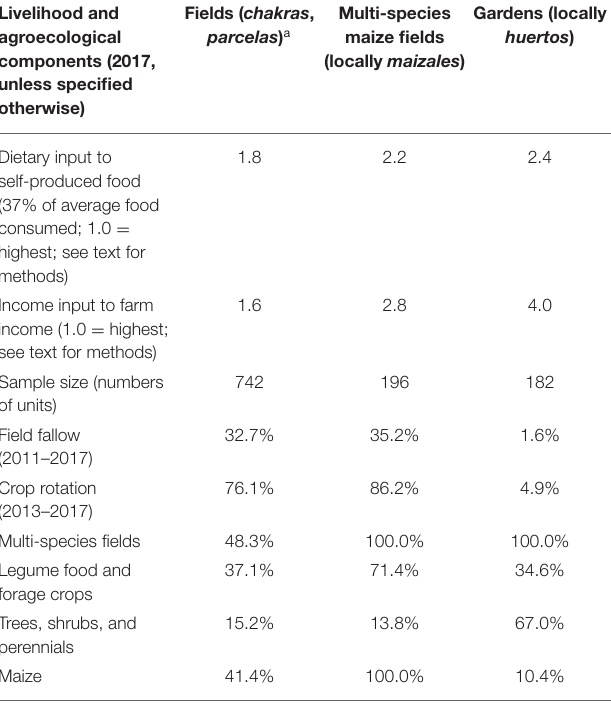
TABLE 5 | Characterization of key farm and food-producing spaces according to livelihood importance and the frequencies of soil and soil-nutrient management (Huánuco,